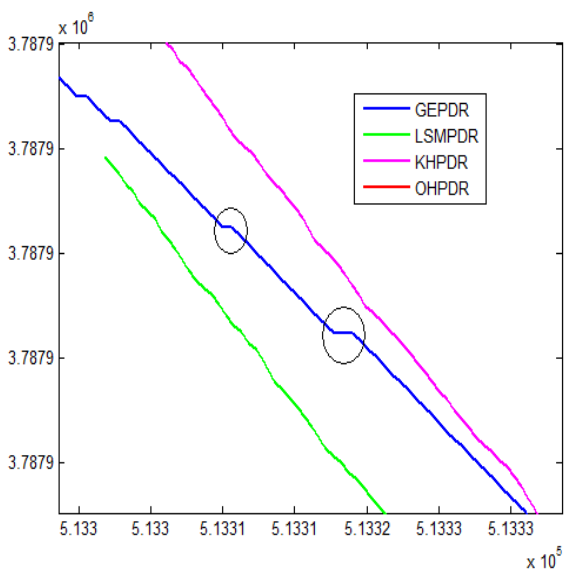
Figure 12. Enlarged view of map constraint error.